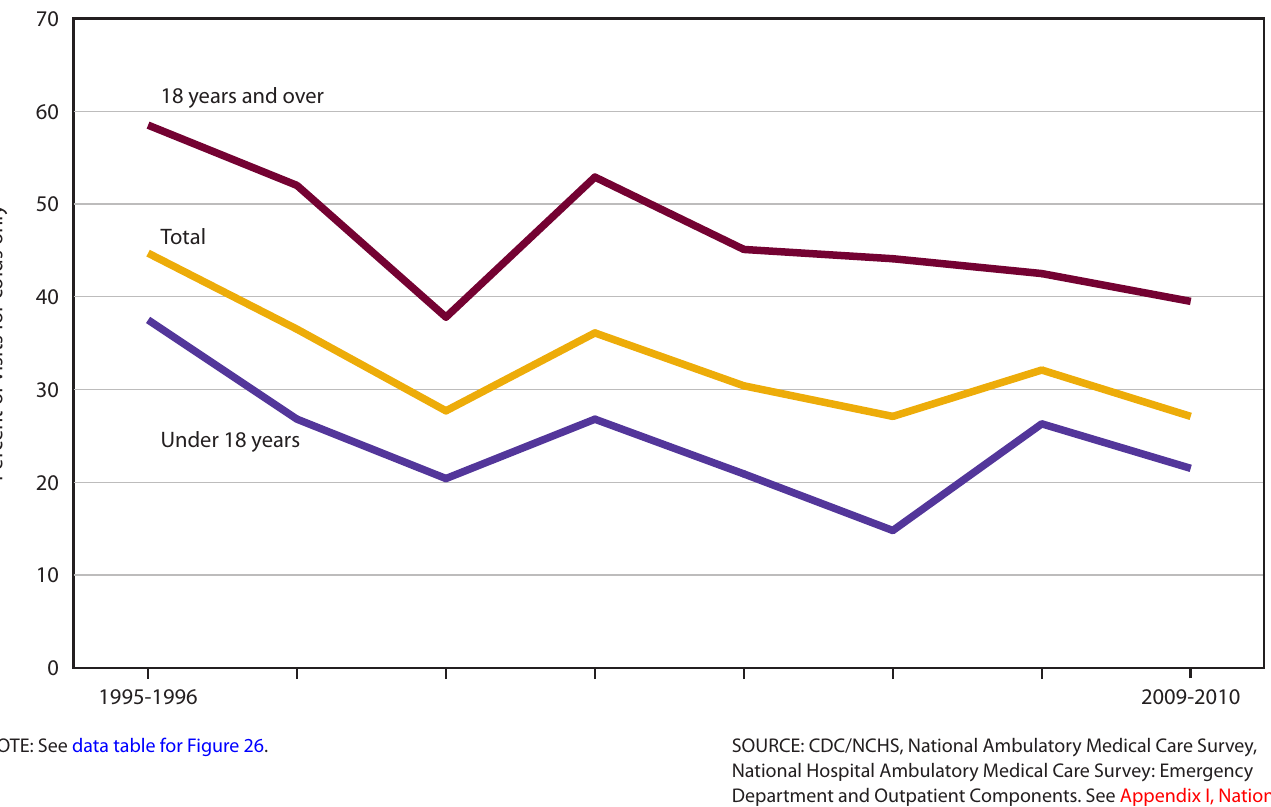
Figure 26. Antibiotics ordered or provided during emergency department, outpatient, and physician visits for